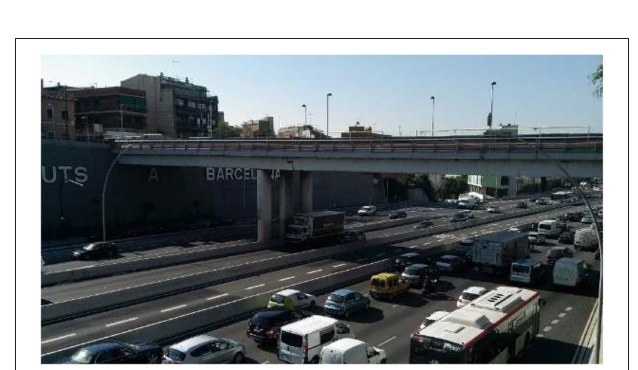
FIGURE 15 | Sarajevo Bridge at Barcelona,